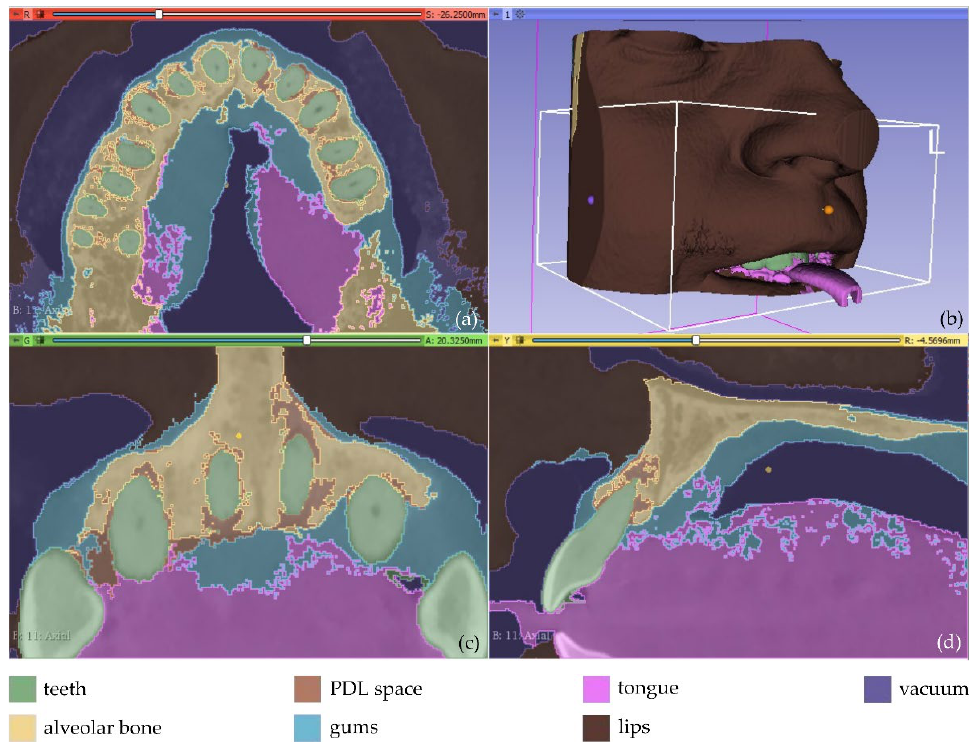
Figure 2. Segmentation results for Experiment 1 after the application of the “Grow from seeds” method via 3D Slicer, superimposed over CBCT slices in the axial plane ( a ), the coronal plane ( c ), and the sagittal plane ( d ), and 3D reconstructed volumes derived by the segmentation ( b ).